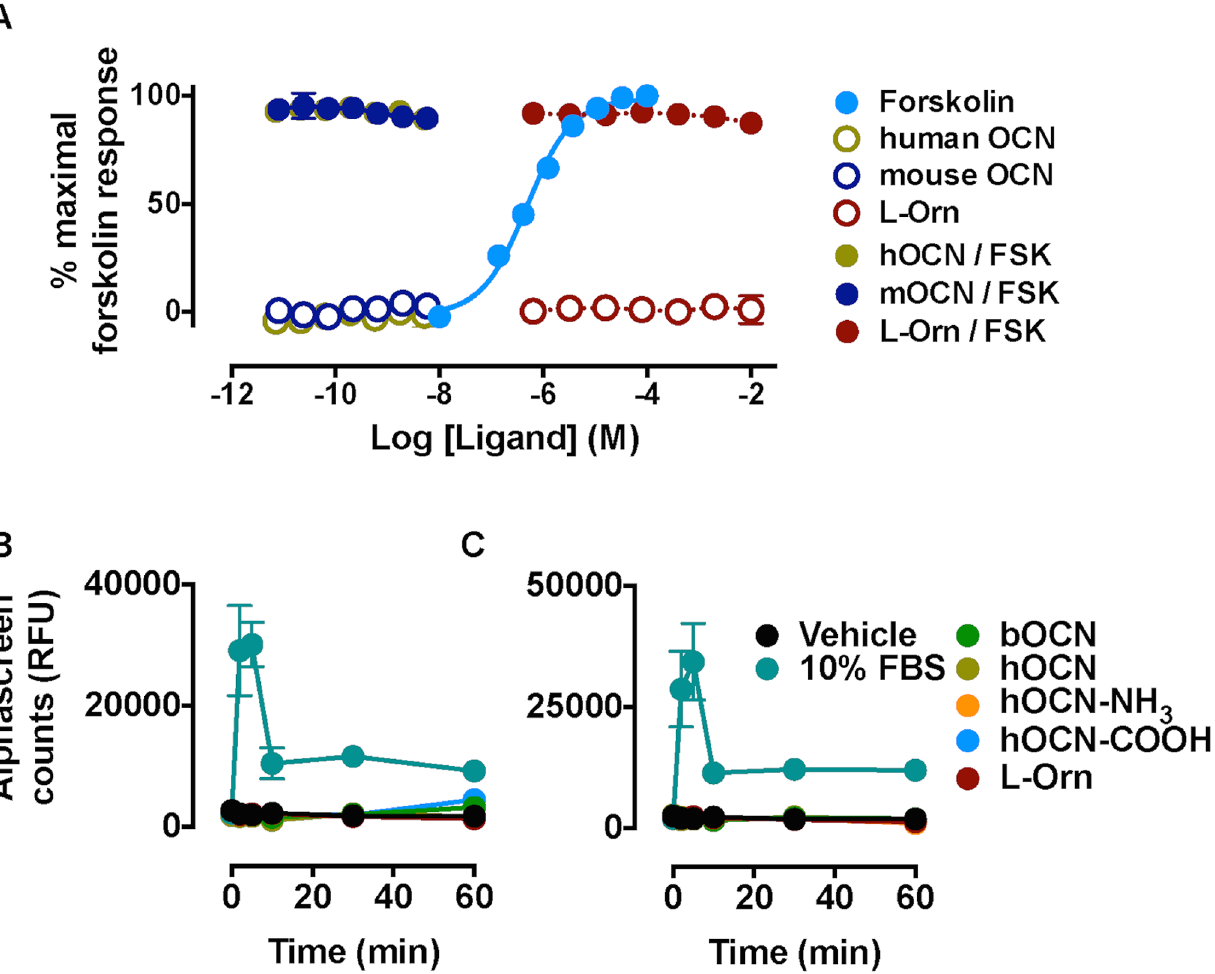
Fig 3. Modulation of cAMP levels and ERK1/2 phosphorylation in FlpIn-TREx-HEK293-mGPRC6A cells. (A) OCN variants do not stimulate cAMP accumulation in FlpIn-TREx-HEK293 cells stably expressing mGPRC6A (open circles). Neither L-ornithine nor OCN variants inhibit forksolin (3 μ M)- stimulated cAMP accumulation in the same cell line (filled circles; OCN variants as described in Table 1). (B) Neither L-ornithine (1 mM) nor OCN variants (40 ng/ml) stimulate ERK1/2 phosphorylation in FlpIn-TREx-HEK293-mGPRC6A cells; (C) a similar lack of activity was observed in cells co-expressing G α qG66D